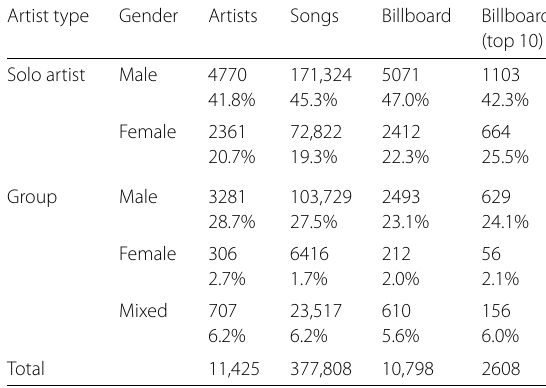
Table 1 Basic statistics of the